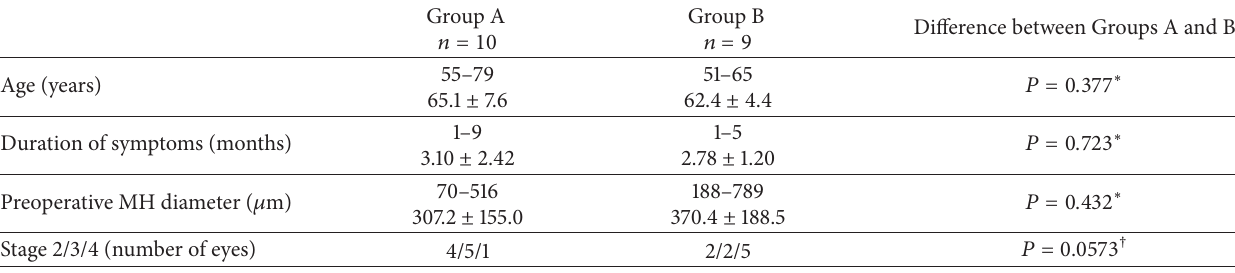
Table 1: Characteristics of two